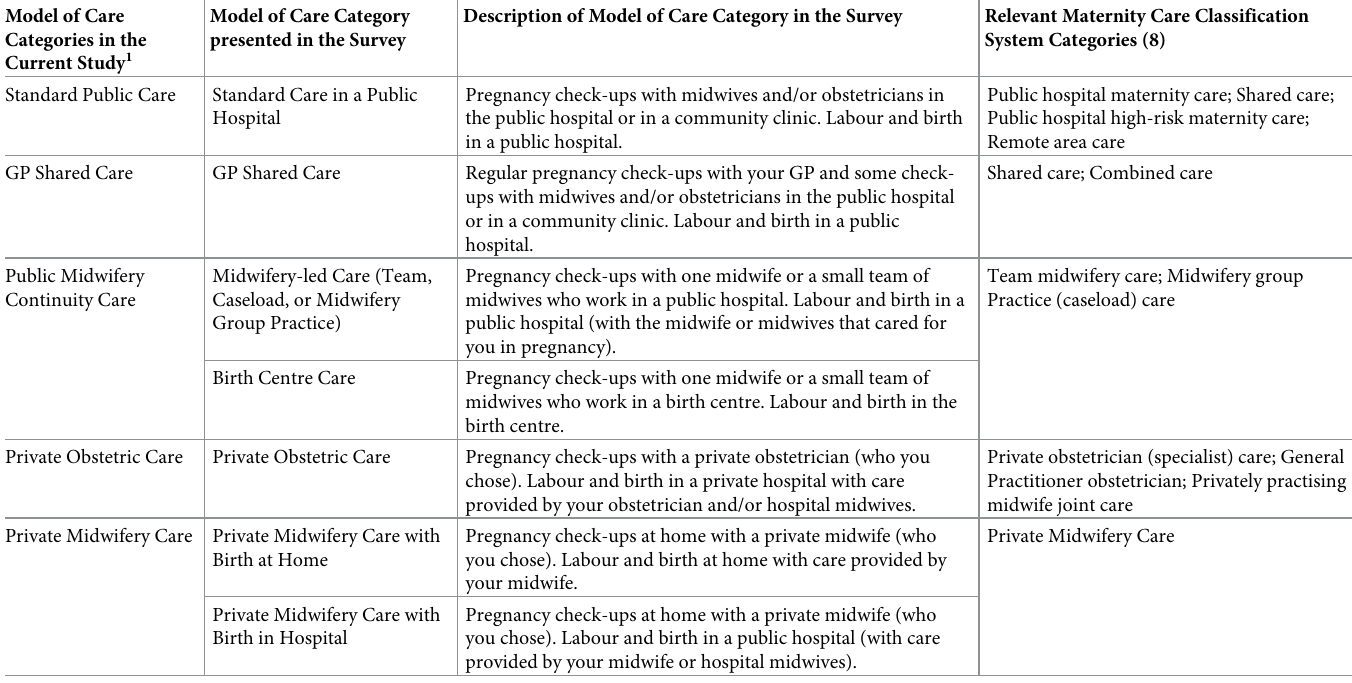
Table 2. Maternity model of care definitions in the current study and their relationship to the current Maternity Care Classification System (MaCCs) in Australia